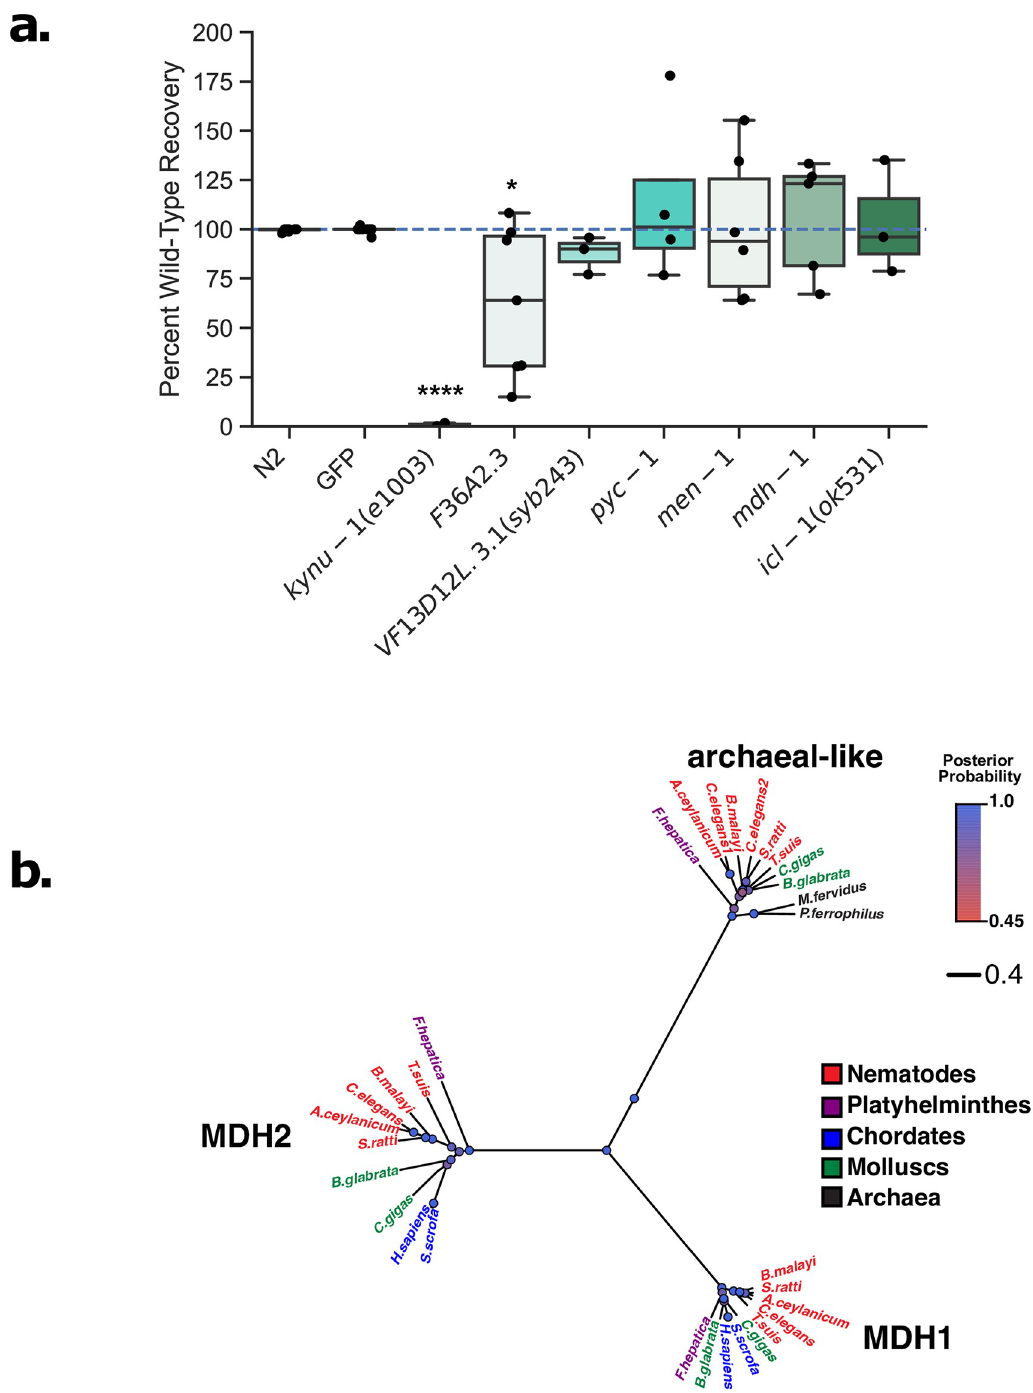
Fig 5. Requirement for various metabolic enzymes for RQ-dependent metabolism. (a) The involvement of various metabolic enzymes in RQ-dependent metabolism was tested using either loss-of-function mutants or RNAi knockdown. Wild-type, mutants, and RNAi-treated L1 worms were exposed to 200 μ M KCN for 15 h followed by a 6-fold dilution, and worm movement was measured after 3 h recovery. For loss-of-function mutants, movement scores were compared to wild-type N2 worms, while for RNAi-treated worms, scores were compared to RNAi against a GFP control. Data show movement scores after 3 h recovery and represent biological replicates, with 2–3 technical replicates in each. (b) Evolutionary tree of the three types of malate dehydrogenase found in helminths as calculated by BEAST [119] (see Materials and methods) and visualized with FigTree. The colour of the circles reflects their posterior probability with the more blue being the most likely. Unlike hosts, helminths possess a third malate dehydrogenase which is more closely related to archaean MDHs